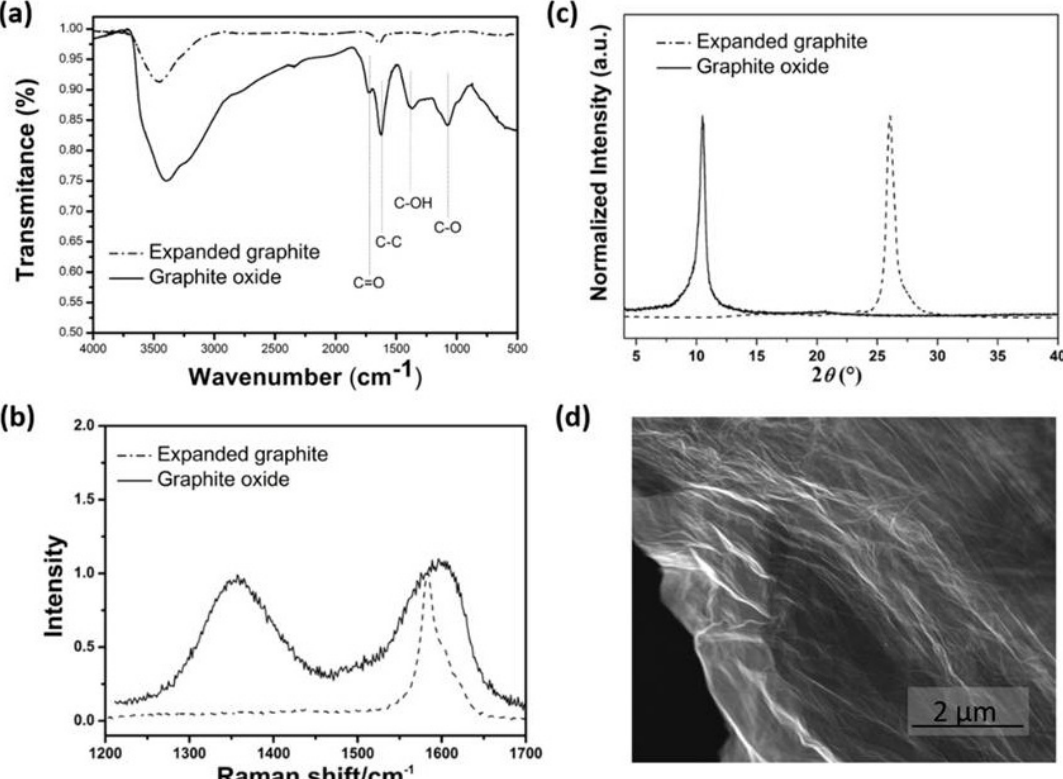
Figure 1. Graphite oxide structural and morphological characterization. FTIR (a), Raman (b), XRD (c) and STEM micrograph of produced graphite oxide